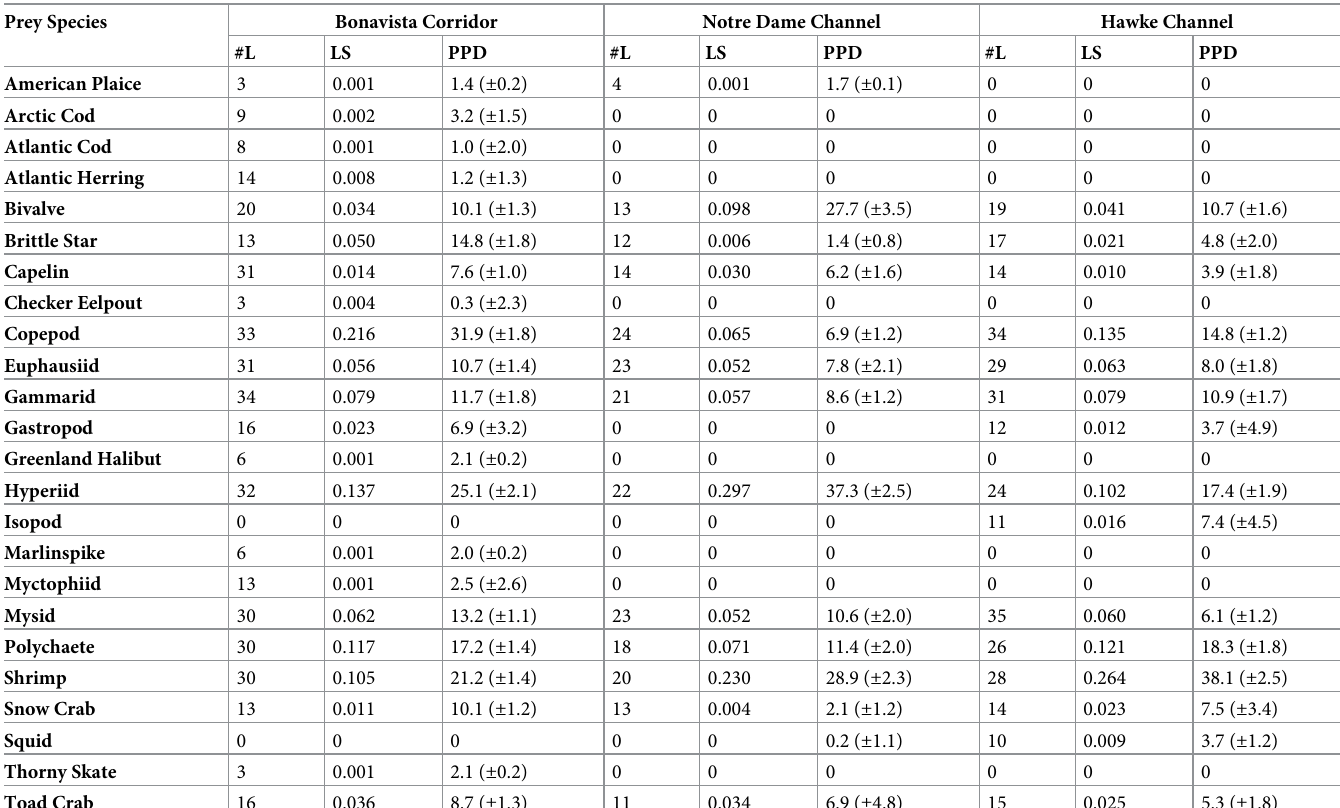
Table 5. Food web link characteristics for the three focus